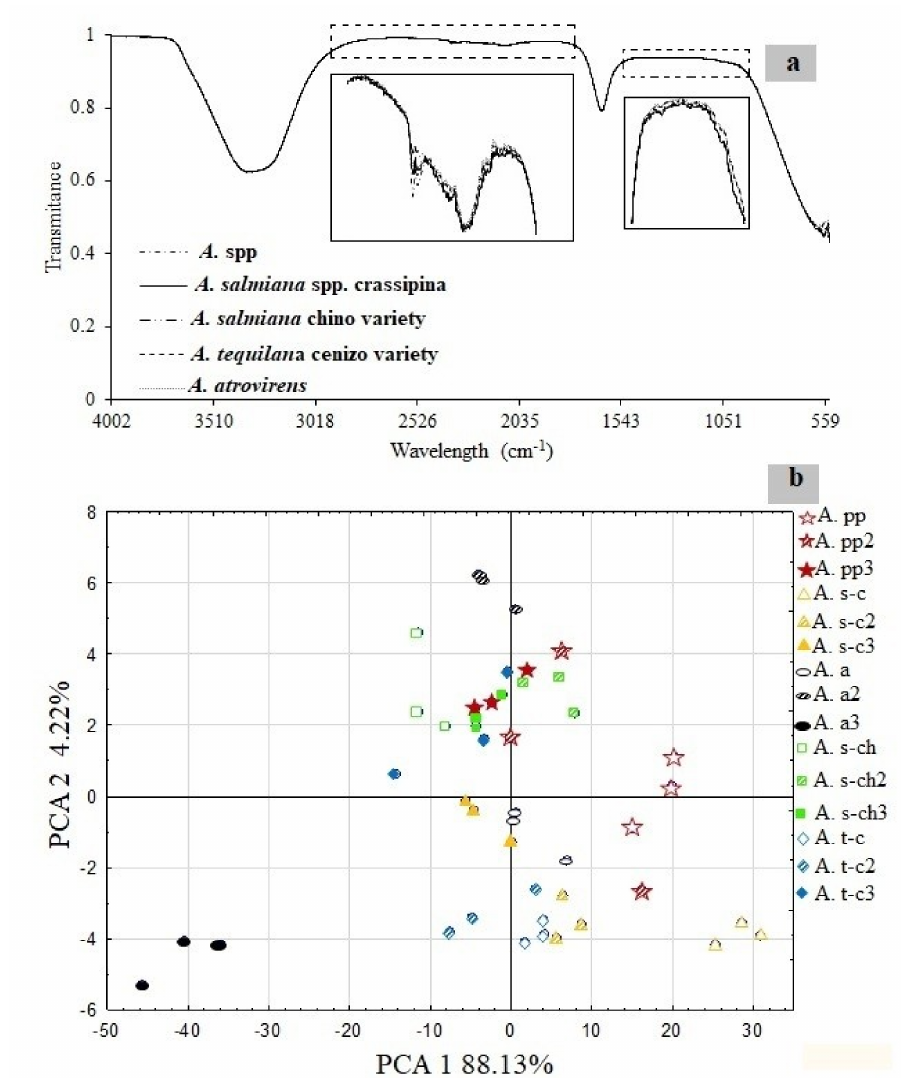
Figure 2. ( a ) Mid-infrared spectroscopy of fructan extracts of five wild agave varieties. ( b ) Principal component analysis of the fructan extracts of five wild agave varieties using only the carbohydrate region (1300–900 cm − 1